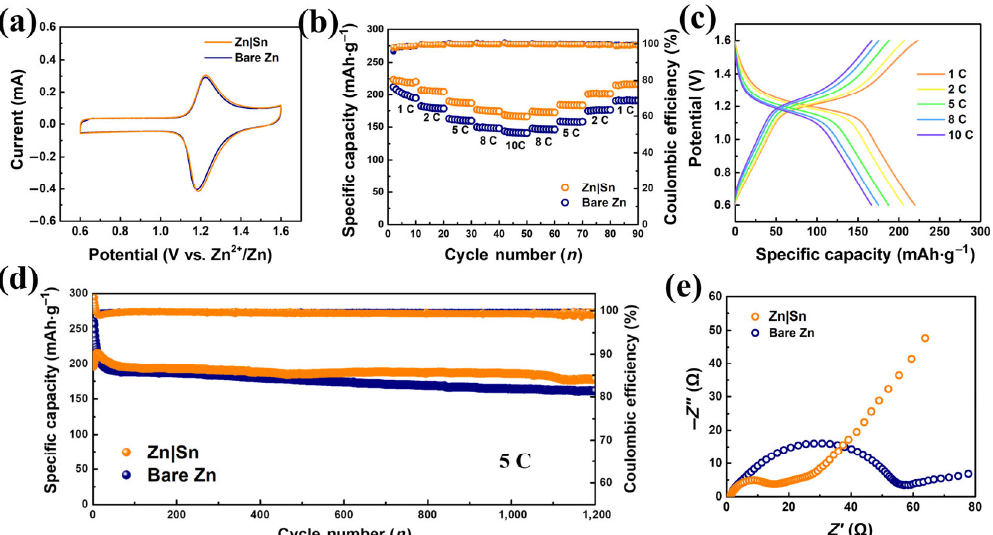
Figure 5 Comparison of electrochemical performance of Zn|Sn and bare Zn in Zn-I 2 batteries. (a) CV curves at 0.1 mV·s −1 . (b) Rate performance of Zn|Sn-I 2 batteries and Zn-I 2 batteries. (c) Corresponding charge/discharge curves under different current densities. (d) Cycling performance and Coulombic efficiency at 5 C. (e) EIS of Zn|Sn-I 2 batteries and Zn-I 2